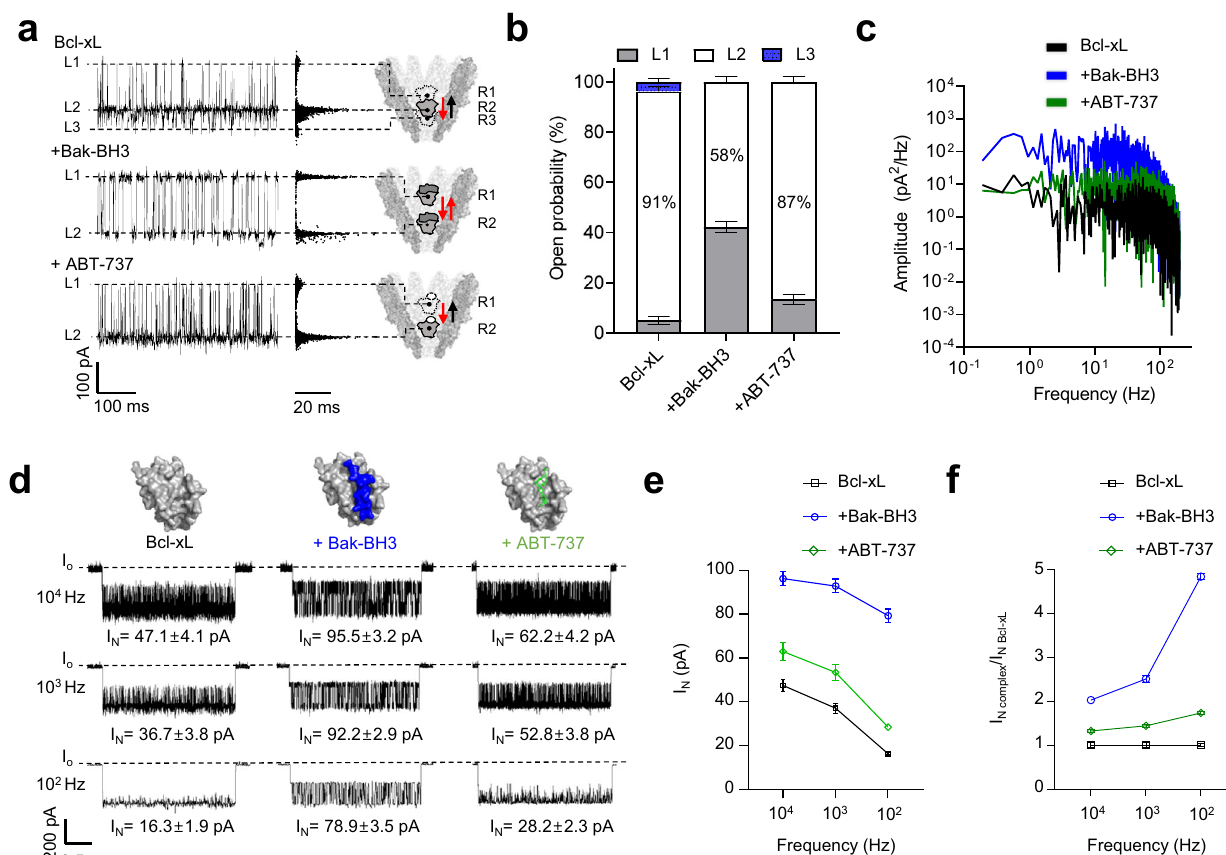
Fig. 3 | Current blockade and noise analyses of protein-ligand interactions using YaxAB nanopores. a Multi-level current blockades, scatter plots (I res vs. duration), and models for residence sites of free Bcl-xL, Bcl-xL/Bak-BH3 (1:2), and Bcl-xL/ABT-737 (1:2)complexes. Basedon the free energy calculation of Bcl-xL and experimentaldataofmulti-levelcurrentblockades,residencesitesofanalyteswere modeled within the YaxAB nanopore. b Stacked columns for the open probability ofL1-L3levelsmeasuredfromcurrentblockadesoffreeBcl-xL,Bcl-xL/Bak-BH3,and Bcl-xL/ABT-737 complexes. Data are presented as mean±SD, n =3 independent replicates. L1 (4.98±1.65%), L2 (91.25±1.89%), and L3 (3.77±1.47%) for free Bcl-xL; L1 (42.13±2.16%), L2 (57.71±2.15%), and L3 (0.16±0.03%) for Bcl-xL/Bak-BH3